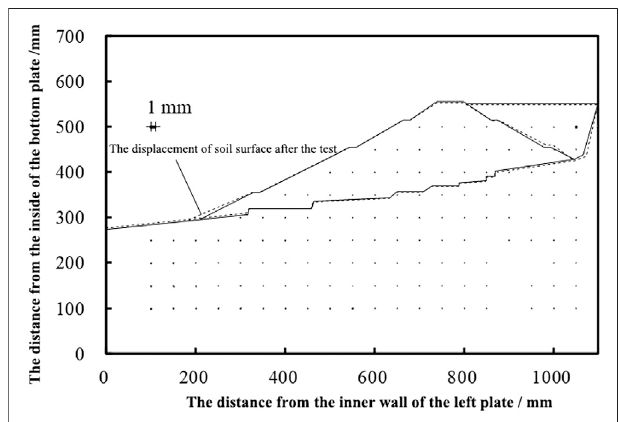
FIGURE 11 | Deformation curve of toe and embankment during long- term operation.